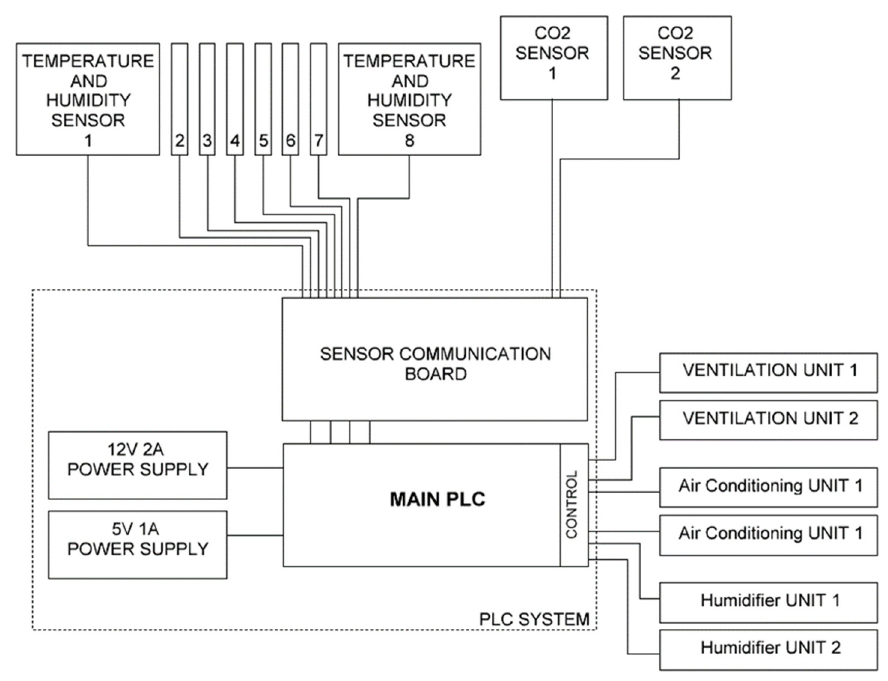
Figure 1. General conceptual diagram of the automatic control system of environmental parameters.